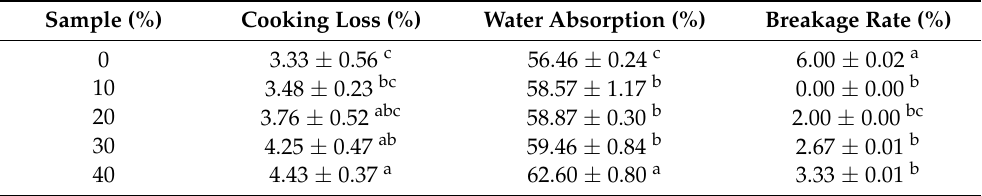
Table 2. Effect of different additions of white kidney bean flour on the cooking of the